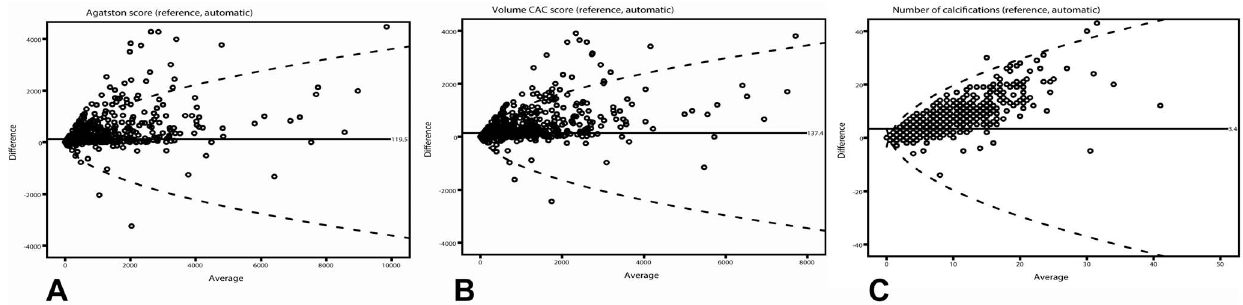
Figure 3. Bland-Altman plots of (A) Agatston, (B) volume, and (C) number of calcifications with 95% limits of agreement (dotted lines). Average score from reference and automated quantification is plotted against difference between the two quantification methods. The plots reveal underestimated calcium scores by automated quantification and an increasing difference with a higher average score. Regression formulas for absolute difference are multiplied by + / 2 1.96*( p /2) 0.5 to get the 95% limits of agreement. For Agatston score: Y=( 2 64.482 + 15.332 * 6 0.5 )*1.96*( p / 2) 0.5 ; For volume CAC score: Y=( 2 74.202 + 16.530* 6 0.5 )*1.96*( p /2) 0.5 ; and for number of calcifications: Y=( 2 1.743 + 3.073* 6 0.5 )*1.96*( p /2) 0.5 .